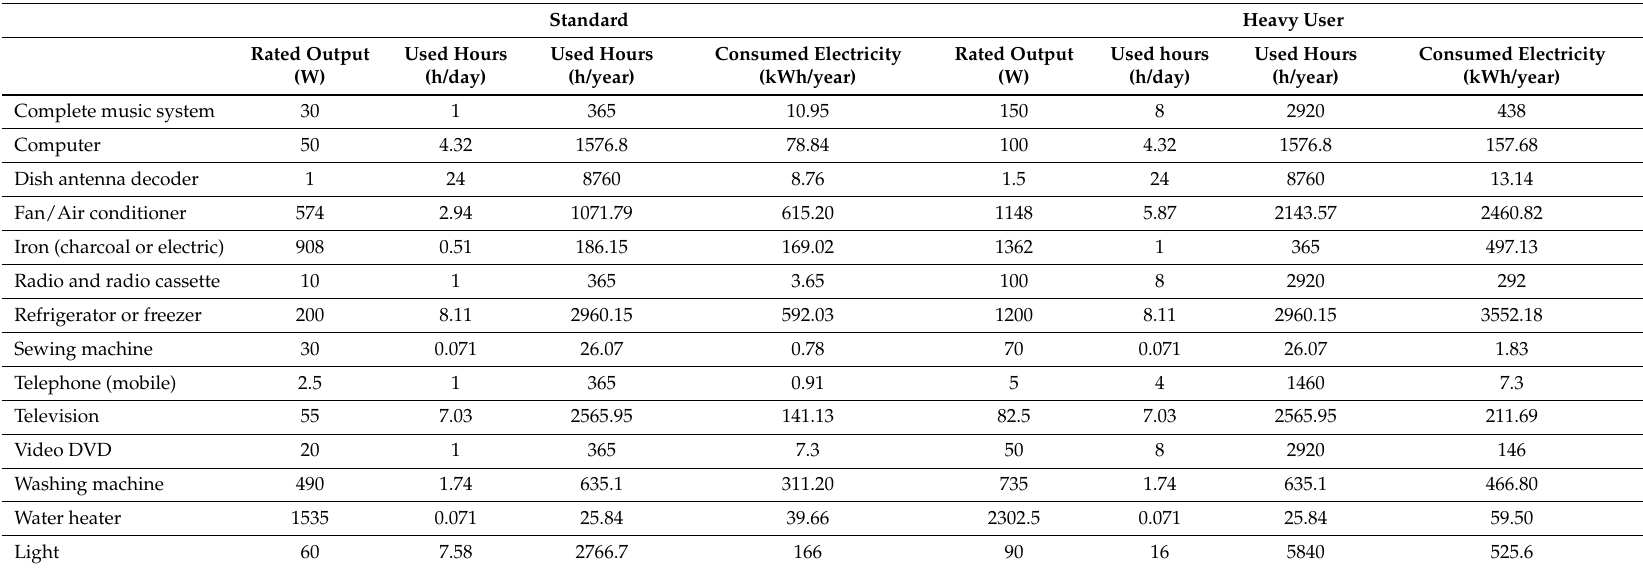
Table 2. Standard and heavy user electricity